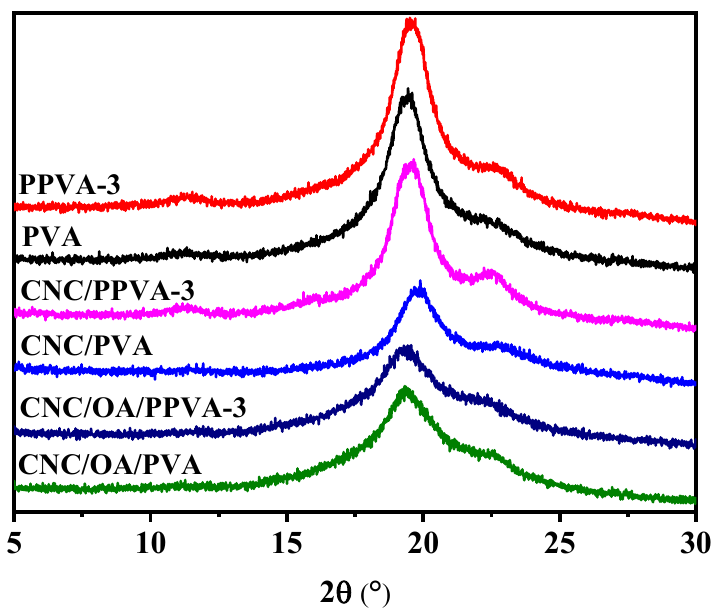
Figure 7. Effect of air plasma on X-ray diffraction patterns of different films before and after air plasma treatment.